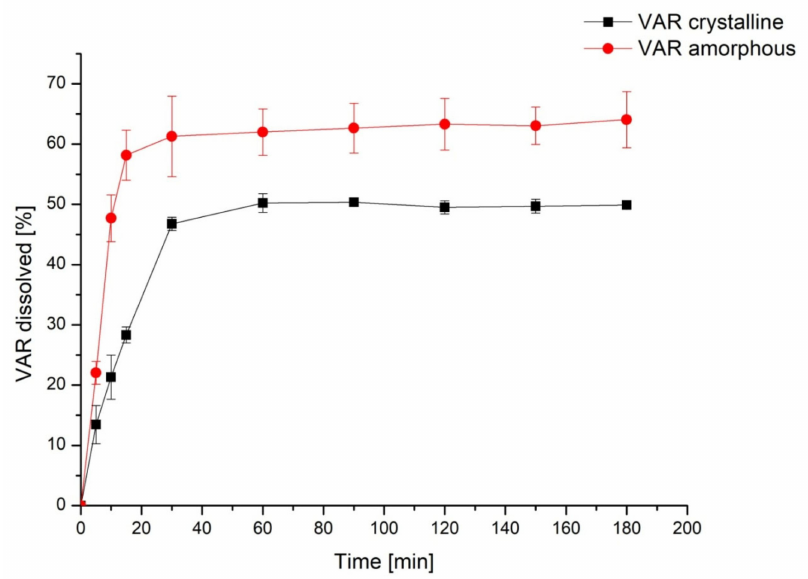
Figure 4. Apparent solubility profiles of crystalline and amorphous forms of VAR. The systems of VAR in crystalline and amorphous form with HPMC and β -CD were created in API:excipient ratio of 1:1 and 1:5. Combinations of the amorphous VAR with HPMC and β -CD were characterized by a faster solubility rate of VAR than its amorphous free form. In addition, the amorphous VAR systems with β -CD and HPMC were characterized by an even higher solubility rate of VAR. The ratio of VAR to the excipients used was also important. For 1:5 systems, greater solubility rate improvements were obtained (Figure 5). The system of 1:5 amorphous VAR: β -CD turned out to enhance the dissolution rate the best.